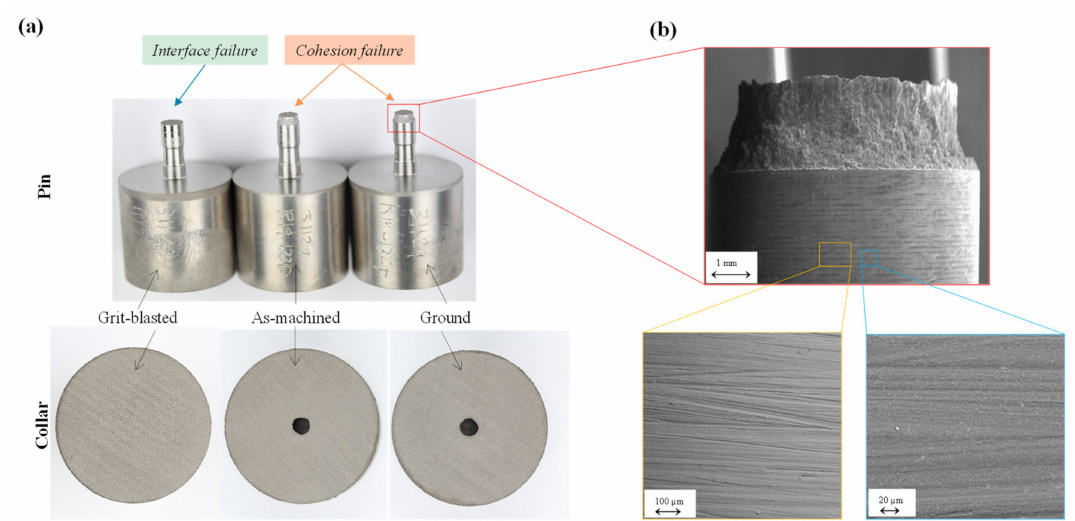
Figure 5. Tested collar-pin pull-off (CPP) specimens: ( a ) failure mechanisms showing interface failure and cohesion failure, ( b ) an enlarged view of the ‘pin’ with cohesion failure, and further magnified images of its sidewall surface showing no evidence of metallurgical bonding between the ‘collar’ and ‘pin’ sidewall surface after STA